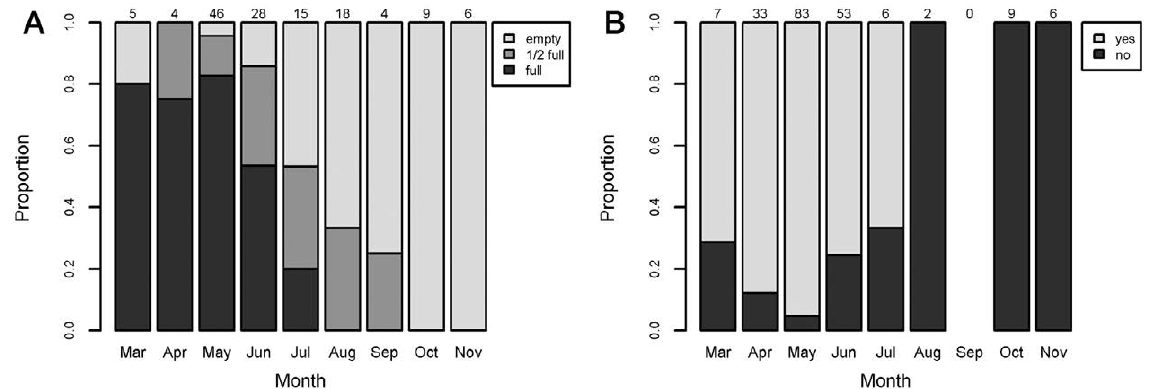
Fig. 1. – Monthly variations in the macroscopic appearance of testes of mature meagre (>80 cm; Tixerant 1974). y -axis represents the propor- tion of monthly samples that registered each feature. A, fullness; B, reaction to abdominal pressure. Numbers above bars are sample